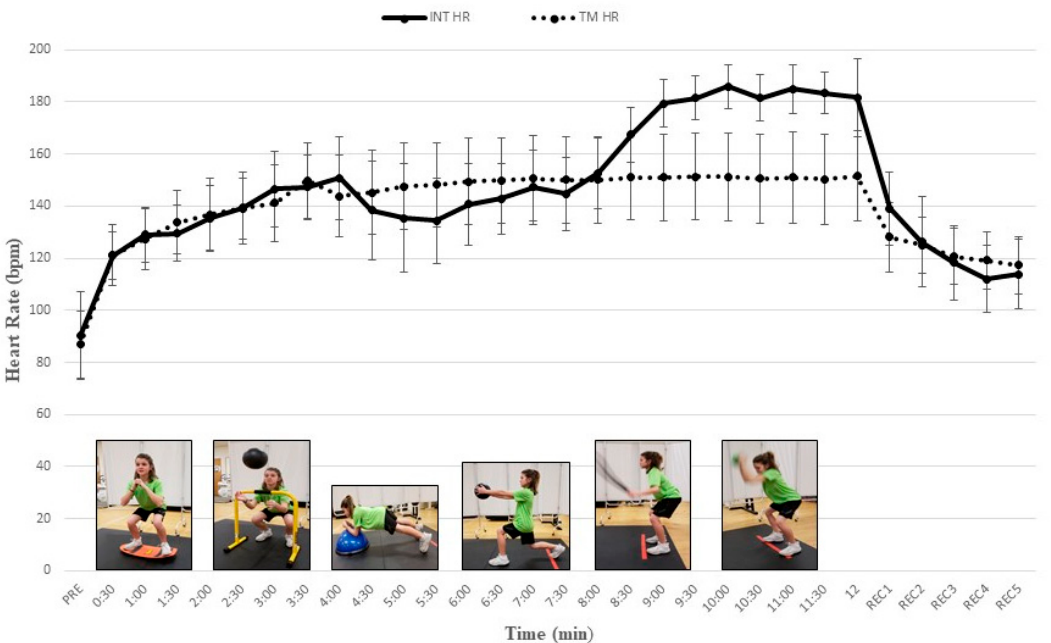
Figure 1. Heart rate (HR) responses (mean ± SD) during integrative neuromuscular training (INT) and treadmill (TM) protocols. PRE = Baseline; REC=recovery. See Table 1 for significant differences between INT exercises and protocols.